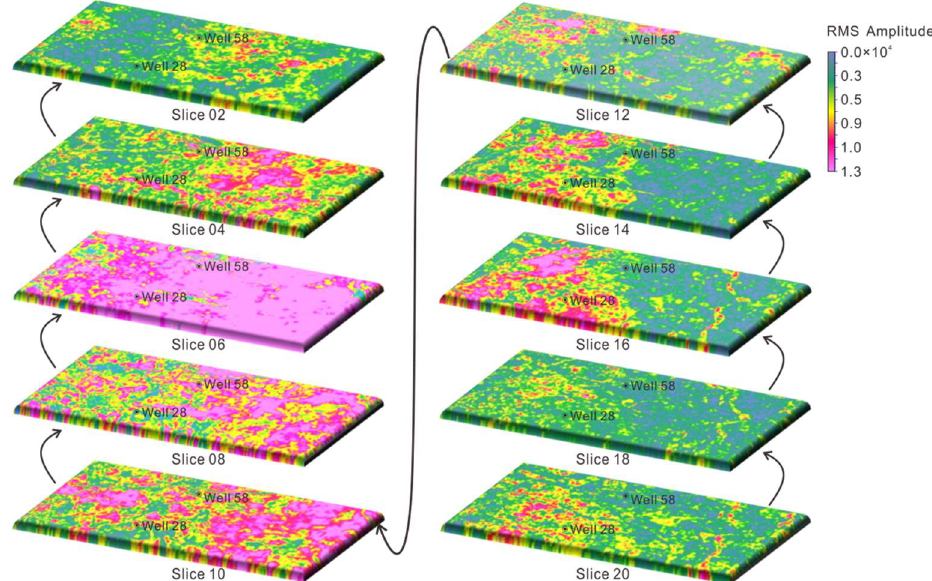
Figure 8. Sedimentary evolution of the target sandstone-type uranium reservoir.